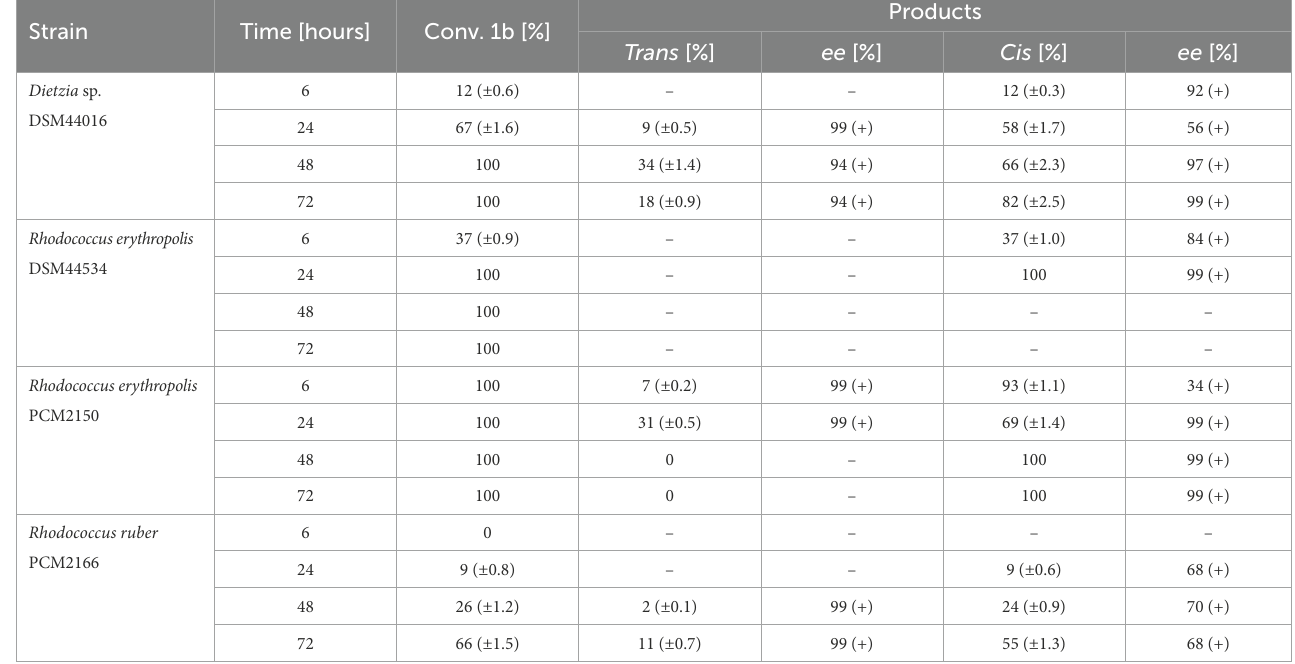
TABLE 4 Results of the biotransformation of syn -3-methyloctane-1,4-diol (1b).